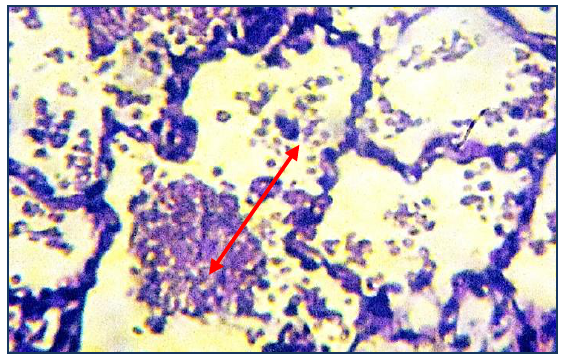
Fig, 4: Histopathological section in the intestine of the cat showing cellular debress in the lumen of mucosal glands (H&Estain 40X).